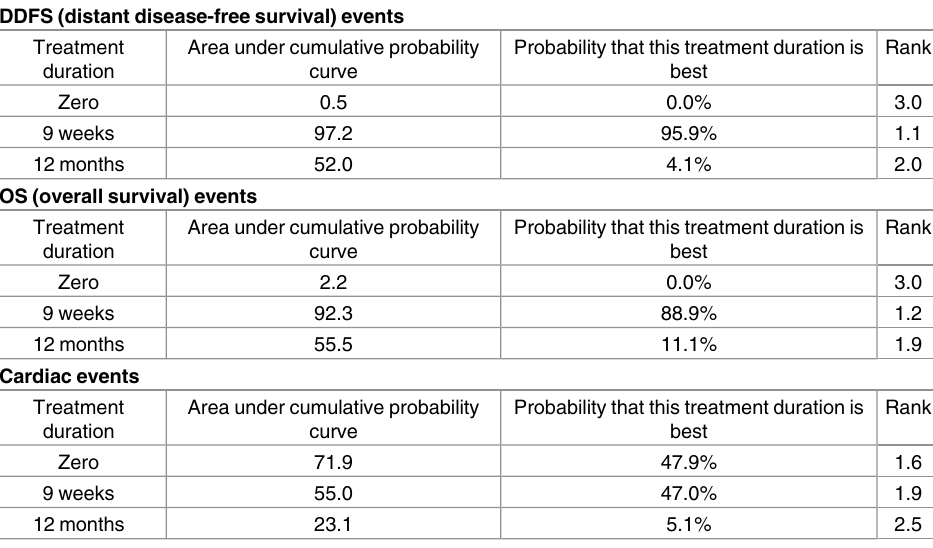
Table 2. SUCRA rankings for BCIRG006/FinHer